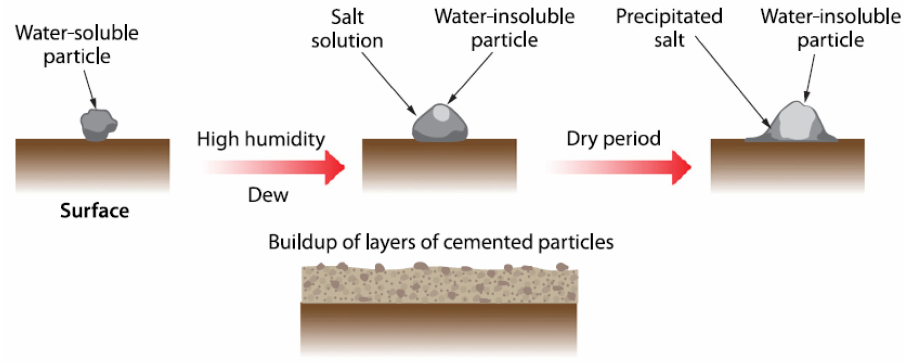
Figure 1. Dust–moisture (water) cementation